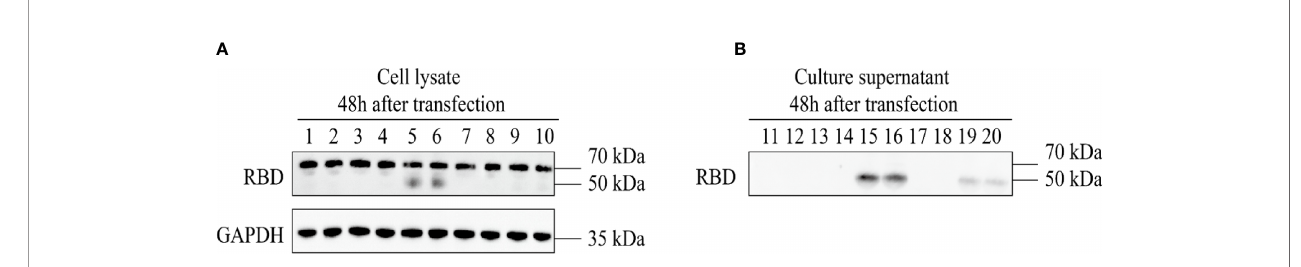
FIGURE 3 | Expression identi fi cation of recombinant AAV9-RBD. The four different AAV vectors were packaged in duplicate and used to infect HeLa cells. The expression of RBD in the cell lysates and supernatants were detected at 48 hours after infection. 1,2: AAV9-EGFP; 3,4: AAV vectors from clone 1; 5,6: AAV vectors from clone 2; 7,8: AAV vectors from clone 3; 9,10: AAV vectors from clone 4. (A) Expression of RBD in the cell lysate at 48 hours after AAV vector infection. (B) Expression of RBD in the culture supernatant at 48 hours after AAV